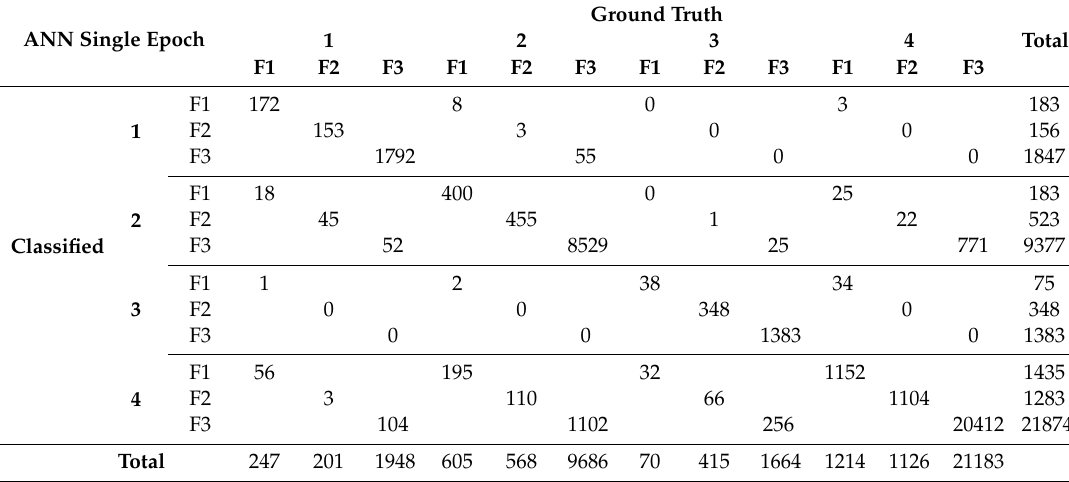
Table A4. Confusion matrix of single epoch classification performed with the Artificial Neural Networks (ANN) classifier. F1 - farm 1, F2 - farm 2 and F3 - farm 3.